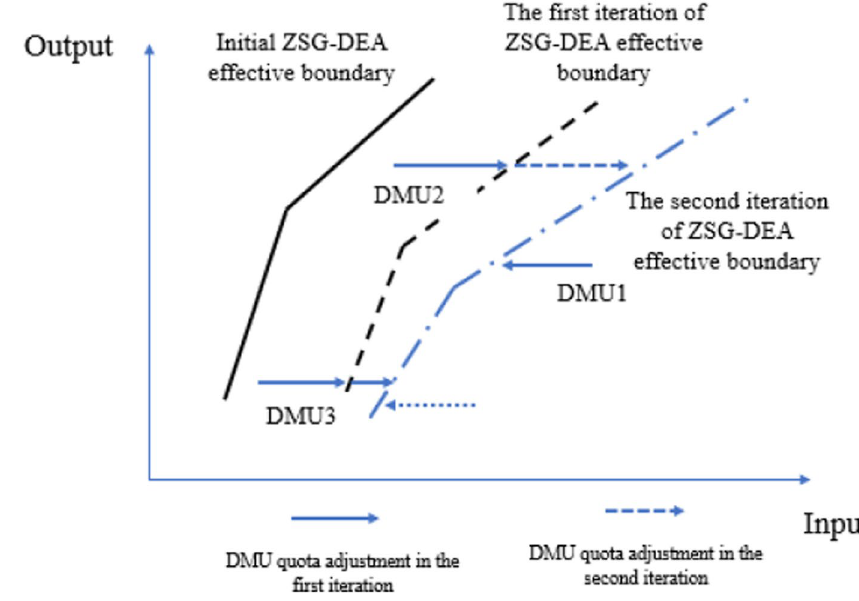
Fig. 1 Forming process of the uniform